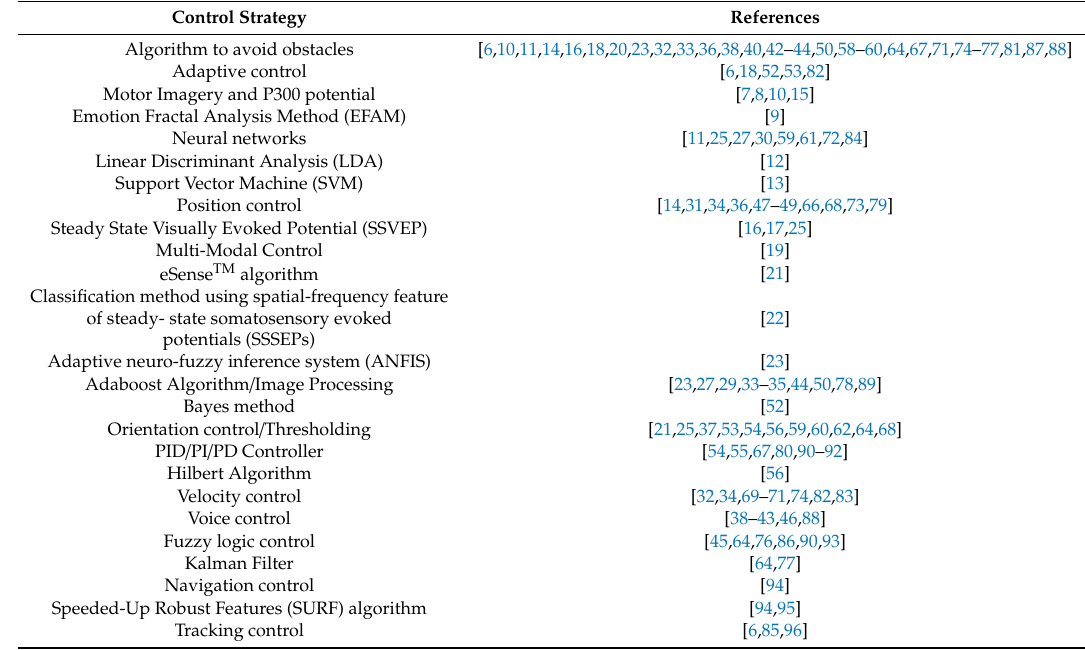
Table 2. Control